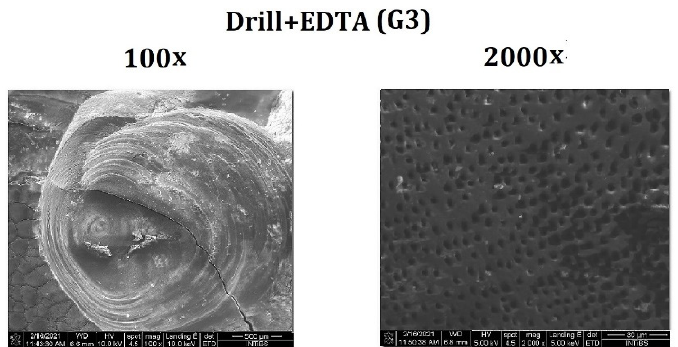
Figure 2. Dentin surface after the composite filling was removed using a diamond drill and 24% EDTA conditioning.